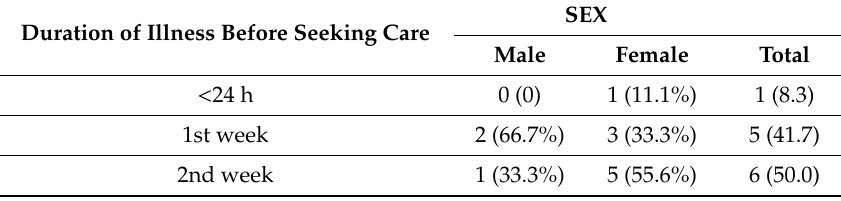
Table 4. Duration of illness and mortality of outborn neonates by sex. Duration of Illness Before Seeking